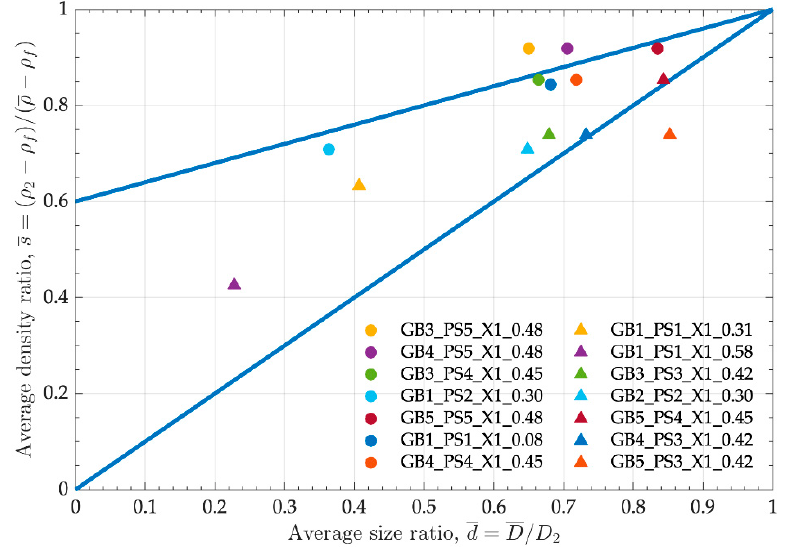
Figure 6. Representative points for the mixtures on the density vs. size ratio map (see Figure 2).